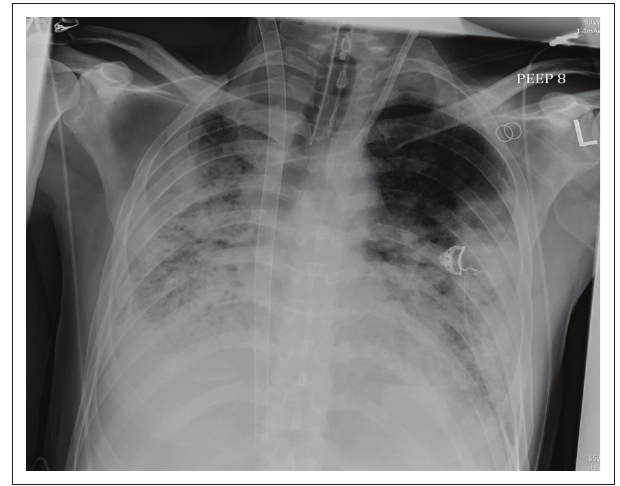
FIGURE 2: Chest radiograph showing a veno-venous extracorporeal membrane oxygenation with the Avalon catheter inserted from the right internal jugular vein directly into the superior vena cava, right atrium and inferior vena cava in a 38-year-old male with idiopathic pulmonary fibrosis.